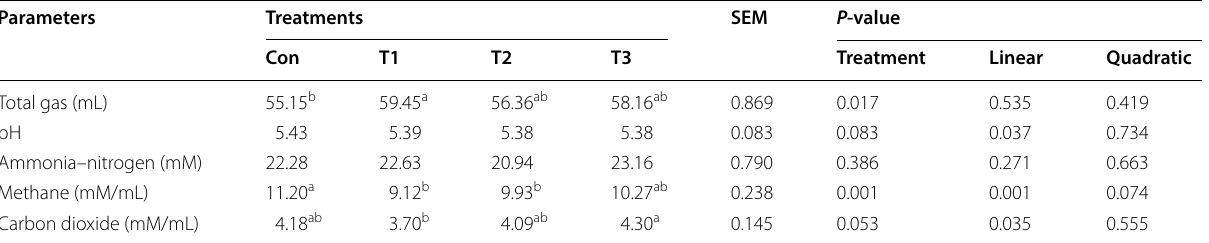
Table 2 Total gas, pH, ammonia–nitrogen, methane, and carbon dioxide concentrations during in vitro rumen fermentation (12